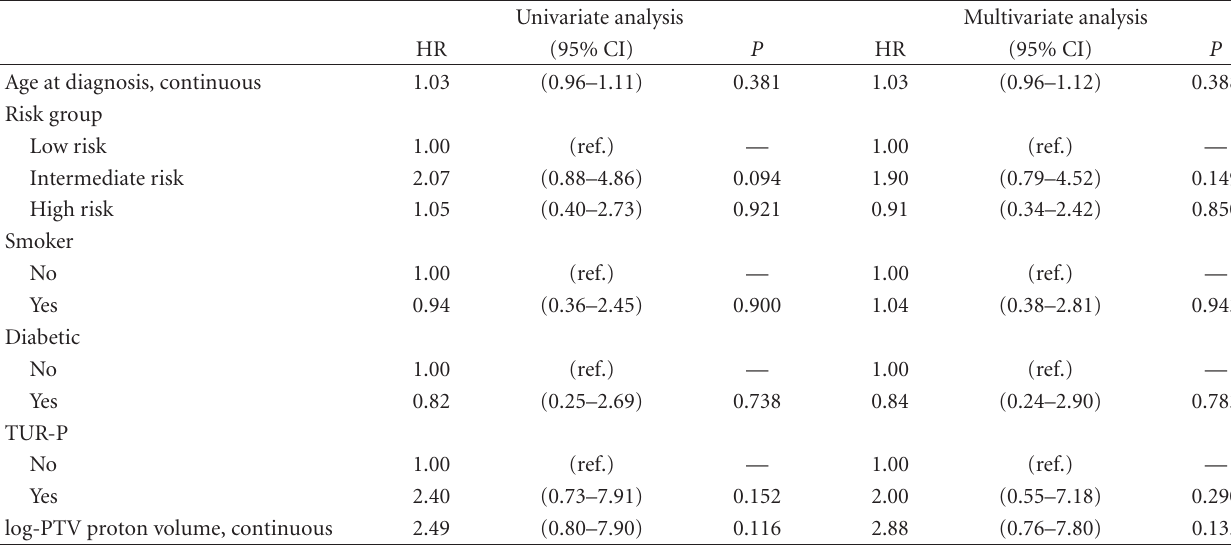
Table 4: Cox regression model—GU grade 2 or higher ∗ . Univariate analysis